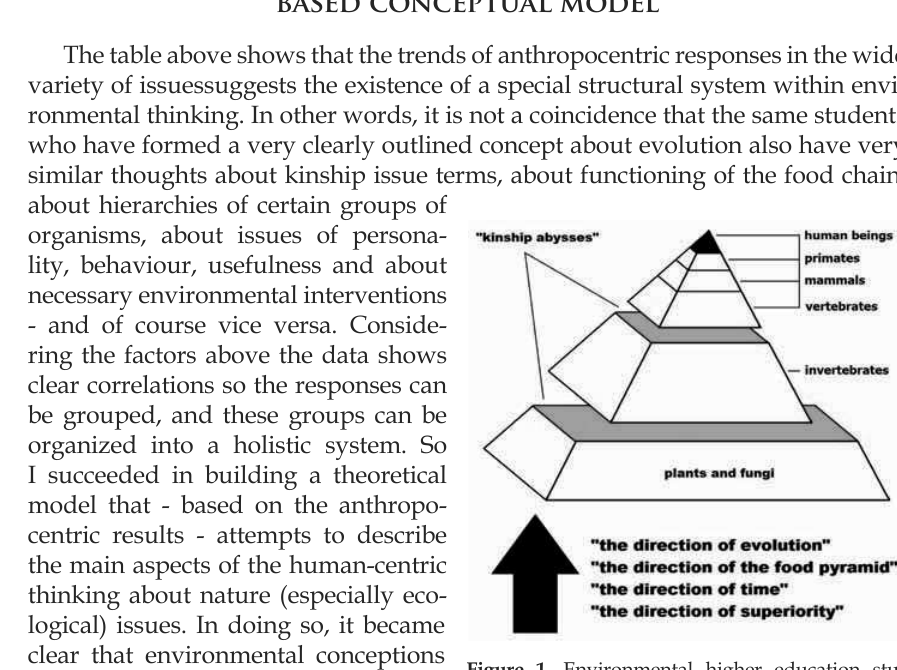
Figure 1 . Environmental higher education stu- dents’ views based model of the anthropocentric ecological